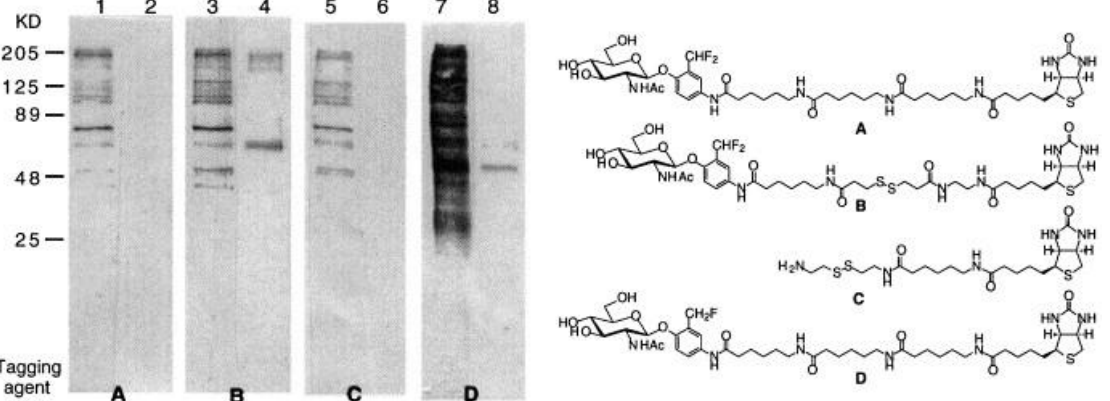
Figure 7. SDS-PAGE visualization of probes A – D before (lines 1, 3, 5, and 7) and after (2, 4, 6, and 8) affinity purification with streptavidin-agarose beads (left) and structure of the synthesized activity probes A – D. Reproduced with permission from [42], copyright 2001 Elsevier .